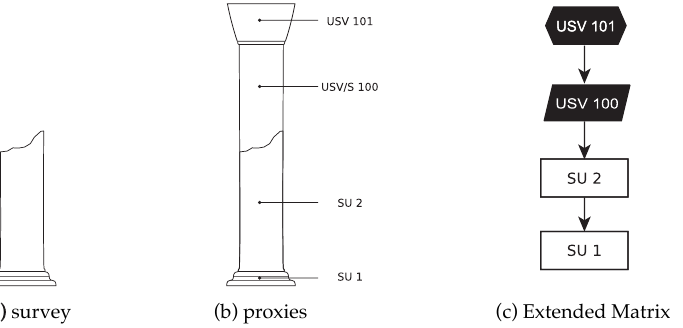
Figure 1. The USV describes potential (virtual) elements in space and time, directly connected to extant remains (USV/s 100) or without any physical connection (USV/n 101). Node shapes and names follow the EM formal language conventions